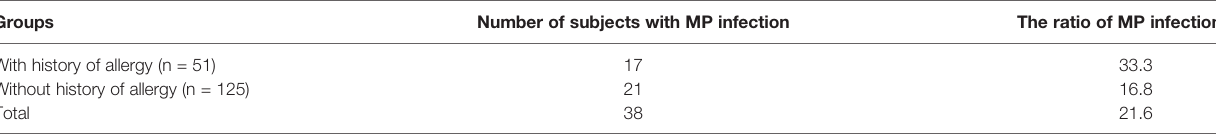
TABLE 4 | The comparison of the ratio of MP infection between groups with and without a history of allergy. Groups Number of subjects with MP infection